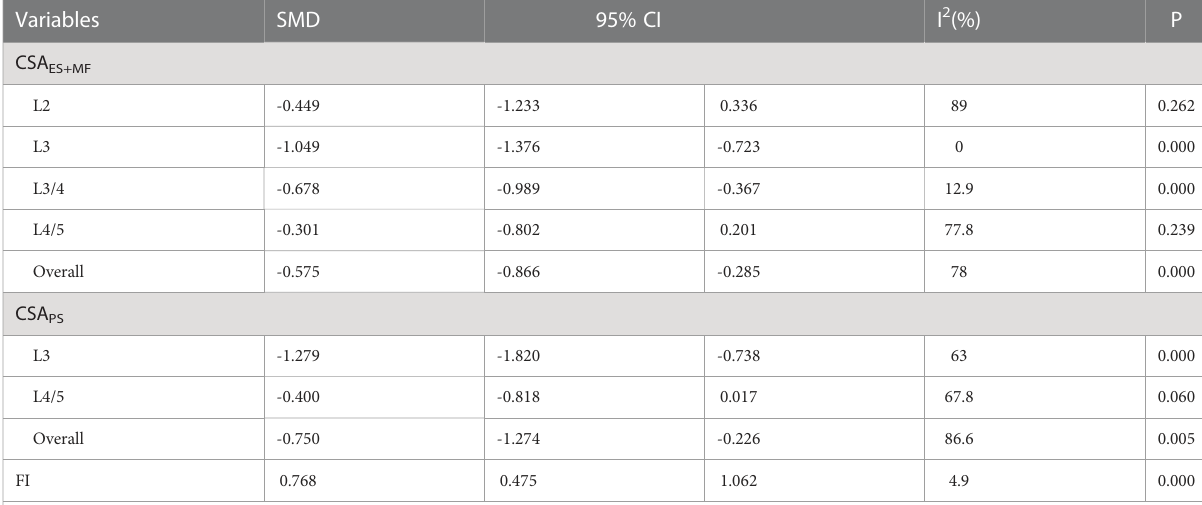
TABLE 2 The pooled analysis of paraspinal muscle characteristics in patients with and without initial OVF.